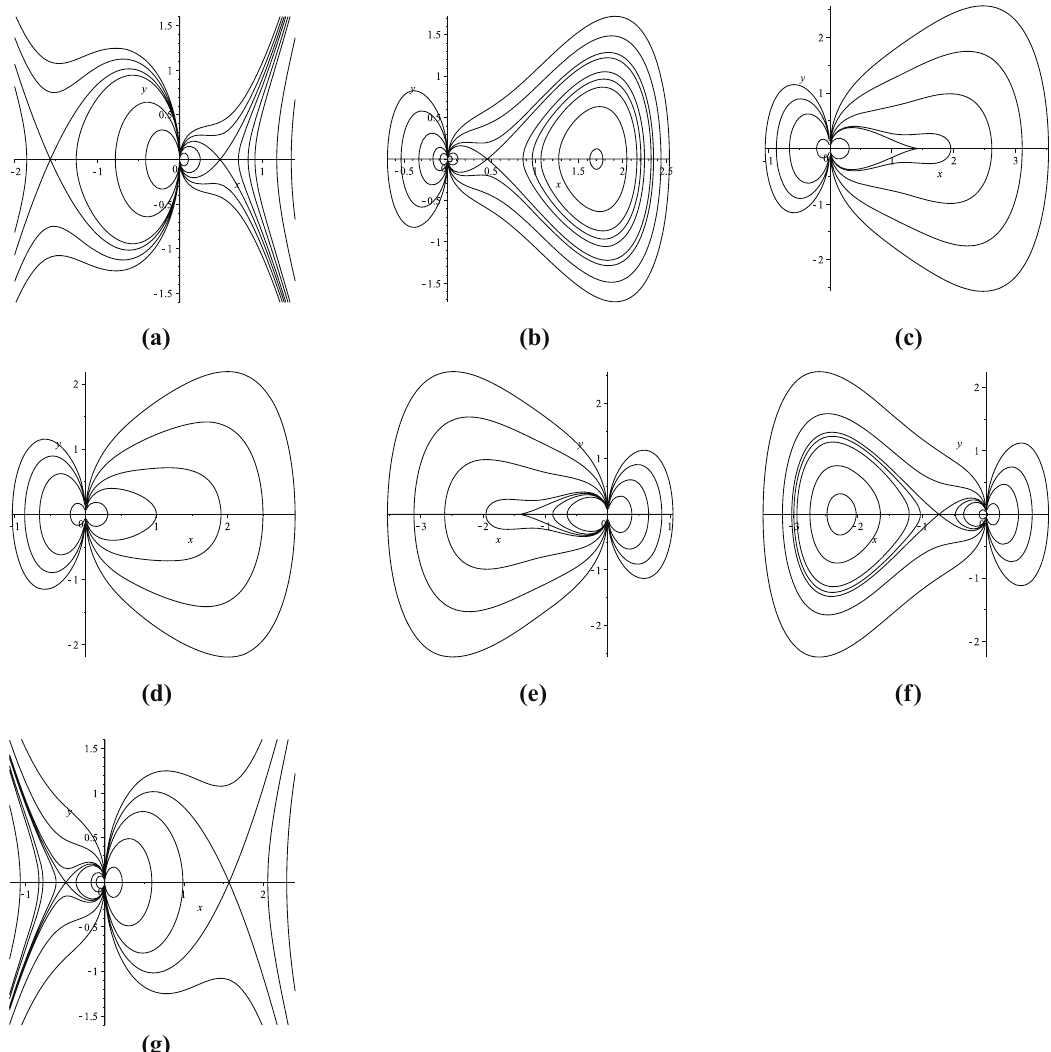
Figure 1: Bifurcations of phase portraits of equation ( 4.6 ) when C 0 < . ( a ) A 0 > and B 0 > , ( b ) A Δ 0, 0 > < , and B 0 > , ( c ) A Δ 0, 0 = < , and B 0 > , ( d ) Δ 0 < and A 0 < , ( e ) Δ 0 = , A 0 < , B 0 < ( f ) Δ 0 > , A 0 < , and B 0 < , ( g ) A 0 > , B 0 >